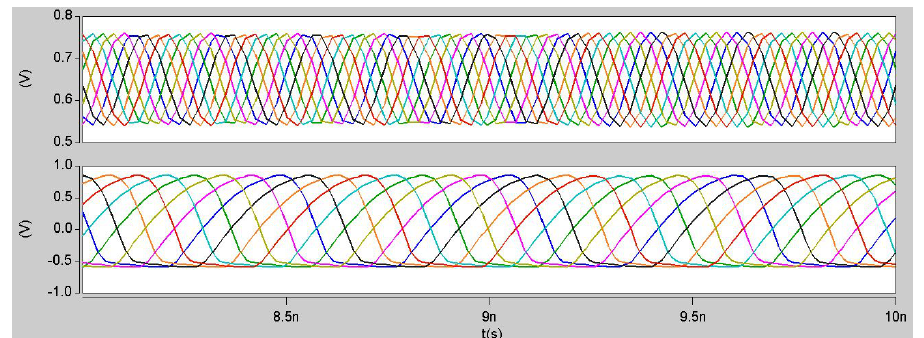
Figure 19. Post-layout output waveforms of the VCO for V ctrl = − 0.9 V ( top ) and V ctrl = − 0.2 V ( bottom